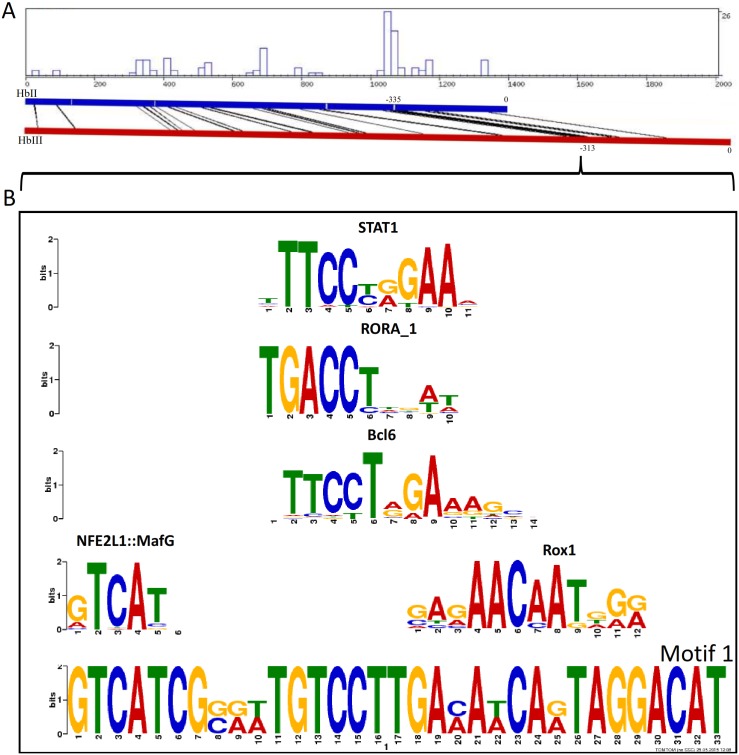
Bioinformatics analysis of the HbII and HbIII promoters.A) Output of the CONREAL web-interface. The results are visualized graphically showing the aligned positions of the HbII and HbIII promoter regions performed using the LAGAN method. The graph show the positions of aligned hits and the distribution/concentration of conserved TFBSs along the sequences. The regions with higher concentration of TFBSs are -335 to -267 for HbII and -313 to -246 for HbIII. Motif 1, 33 bp long, was found by MEME analysis and is located at this region (starts at position -306 in HbII and -288 in HbIII). B) Logo of the motif found by MEME analysis (below, named motif 1) with the first five TFBSs found by TOMTOM analysis against the JASPAR core (2014) database.